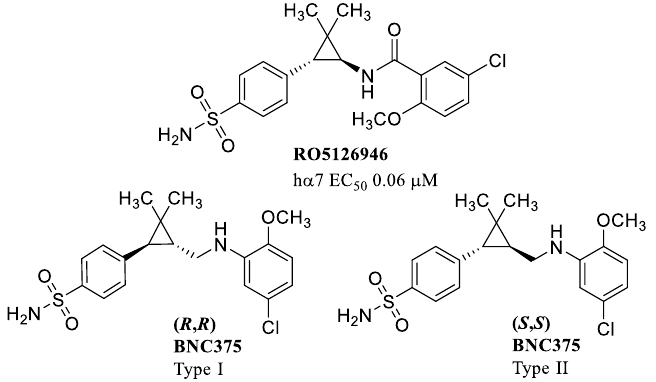
Figure 7. Examples of type I and type II α 7-PAMs with a cyclopropane ring.